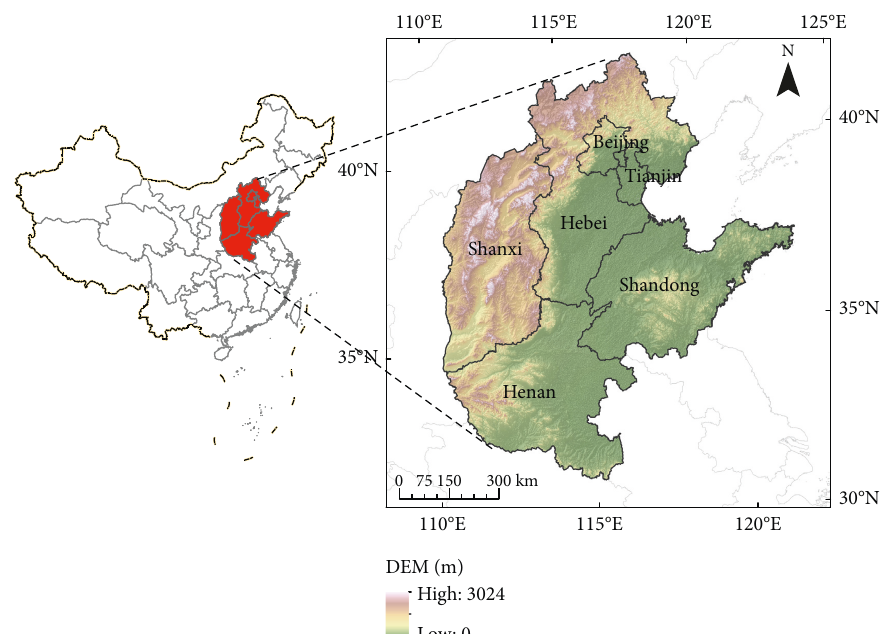
Figure 1: Location of the study area. Table 1: The correlation coefficient between SMAI and SPEI in North China.